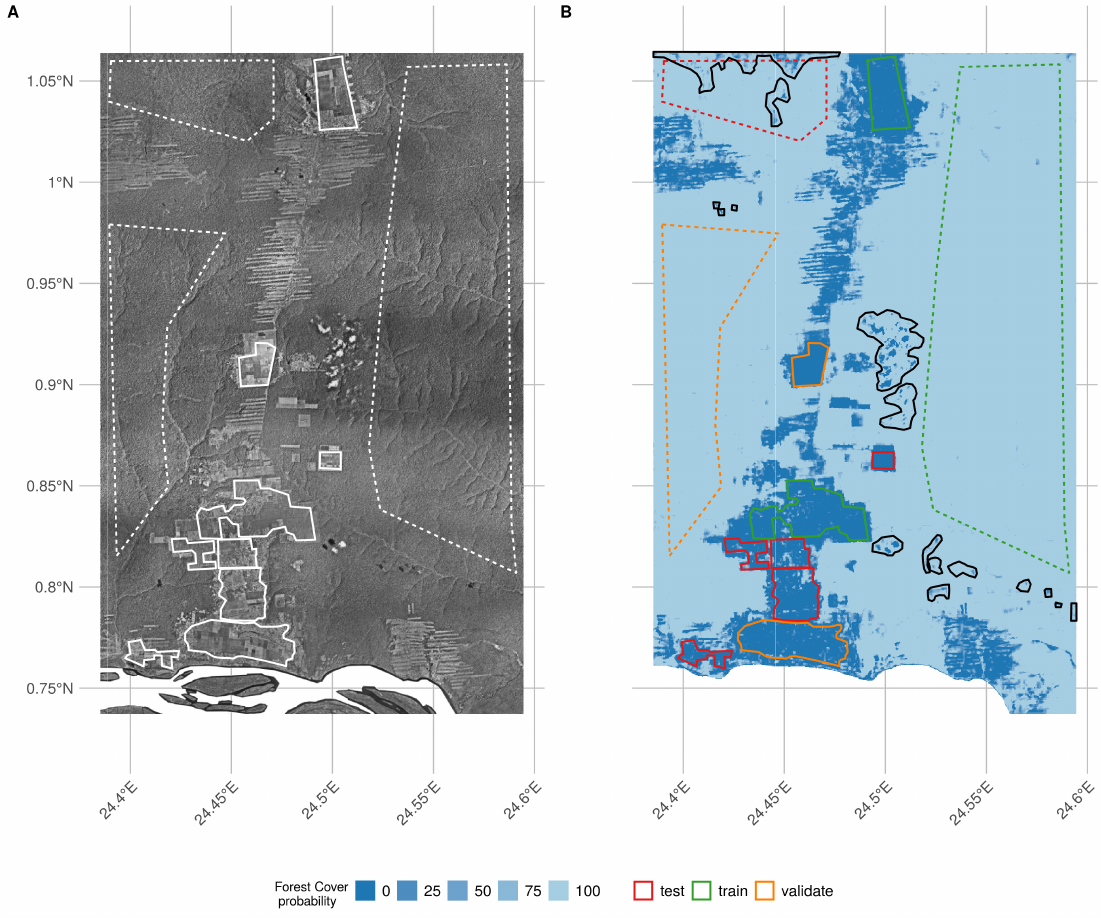
Figure 3. Overview of the final orthomosaic of the greater Yangambi region ( A ) as well as the forest cover classification uncertainty ( B ) used to generate the final land cover map (see Figure 5): Homogeneous polygons used in the generation of the synthetic landscape for convolutional neural network training, testing, and validation are marked as dashed and full lines for forest and non-forest regions, respectively. Training, testing, and validation regions are denoted in panel B in green, red, and orange, respectivelly. Black polygon outlines denote cloud and image stitch line regions which were manually excluded from analysis but retained in calculation of validation statistics (see Table